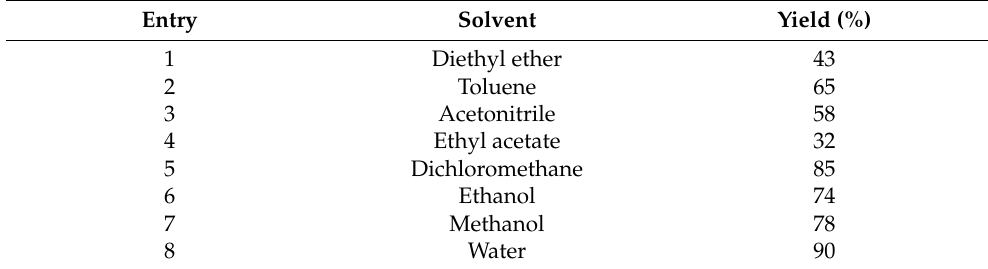
Table 1. Effect of different solvents on the scope of the Passerini reaction.